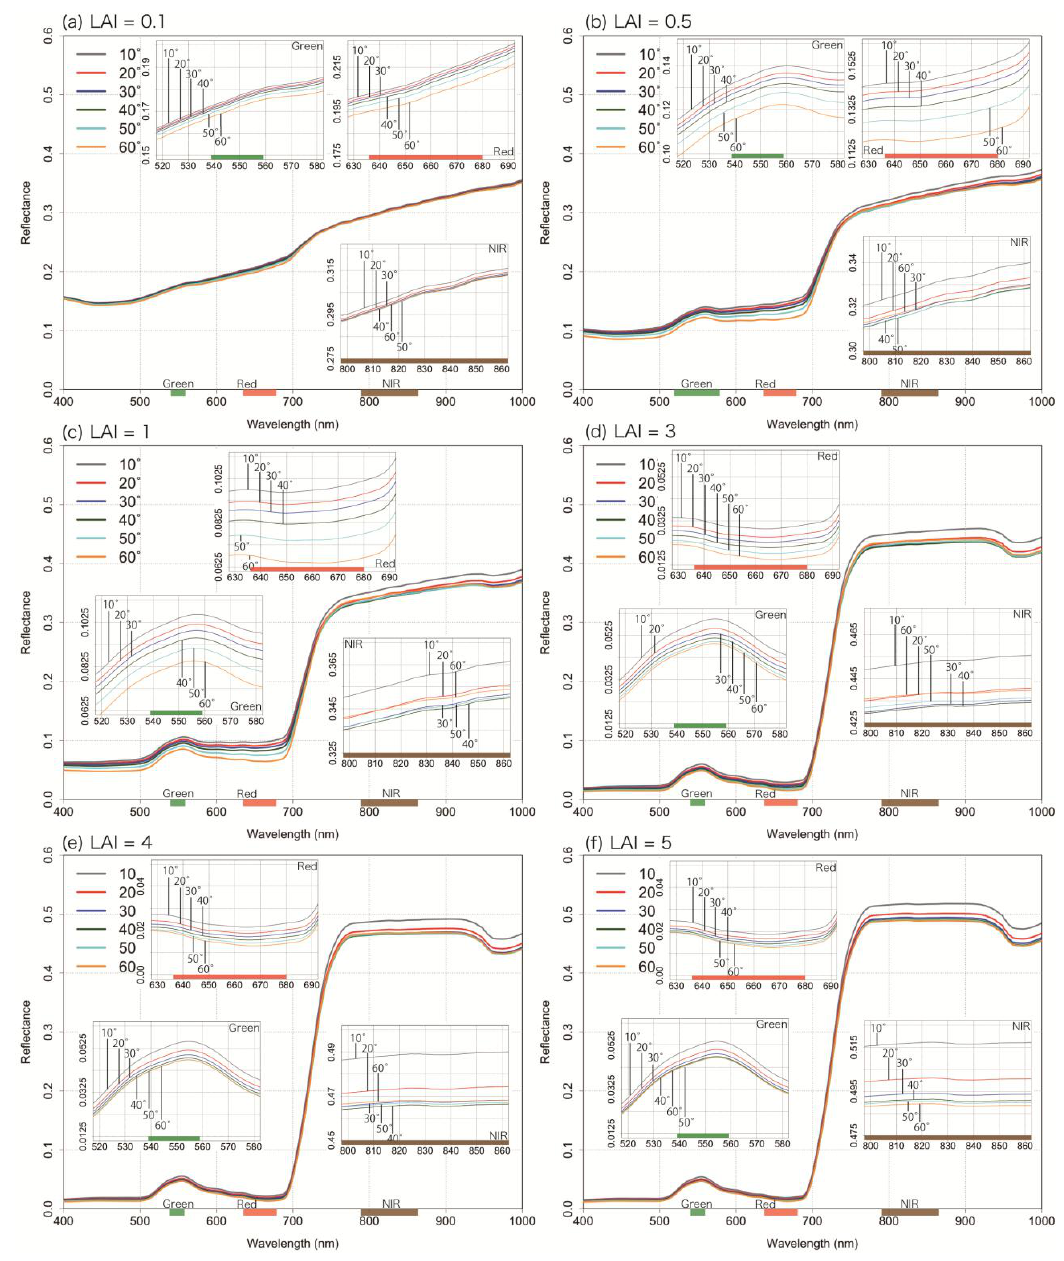
Figure 4. Reflectance spectra simulated using the PROSAIL model for a range of solar zenith angles (10  , 20  , 30  , 40  , 50  , 60  ) and LAI values (( a ) 0.1, ( b ) 0.5, ( c ) 1, ( d ) 3, ( e ) 4, ( f )